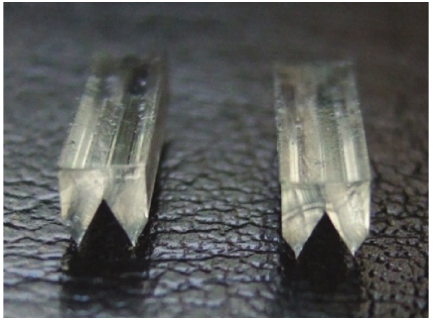
Figure 6: Photograph of ELs.